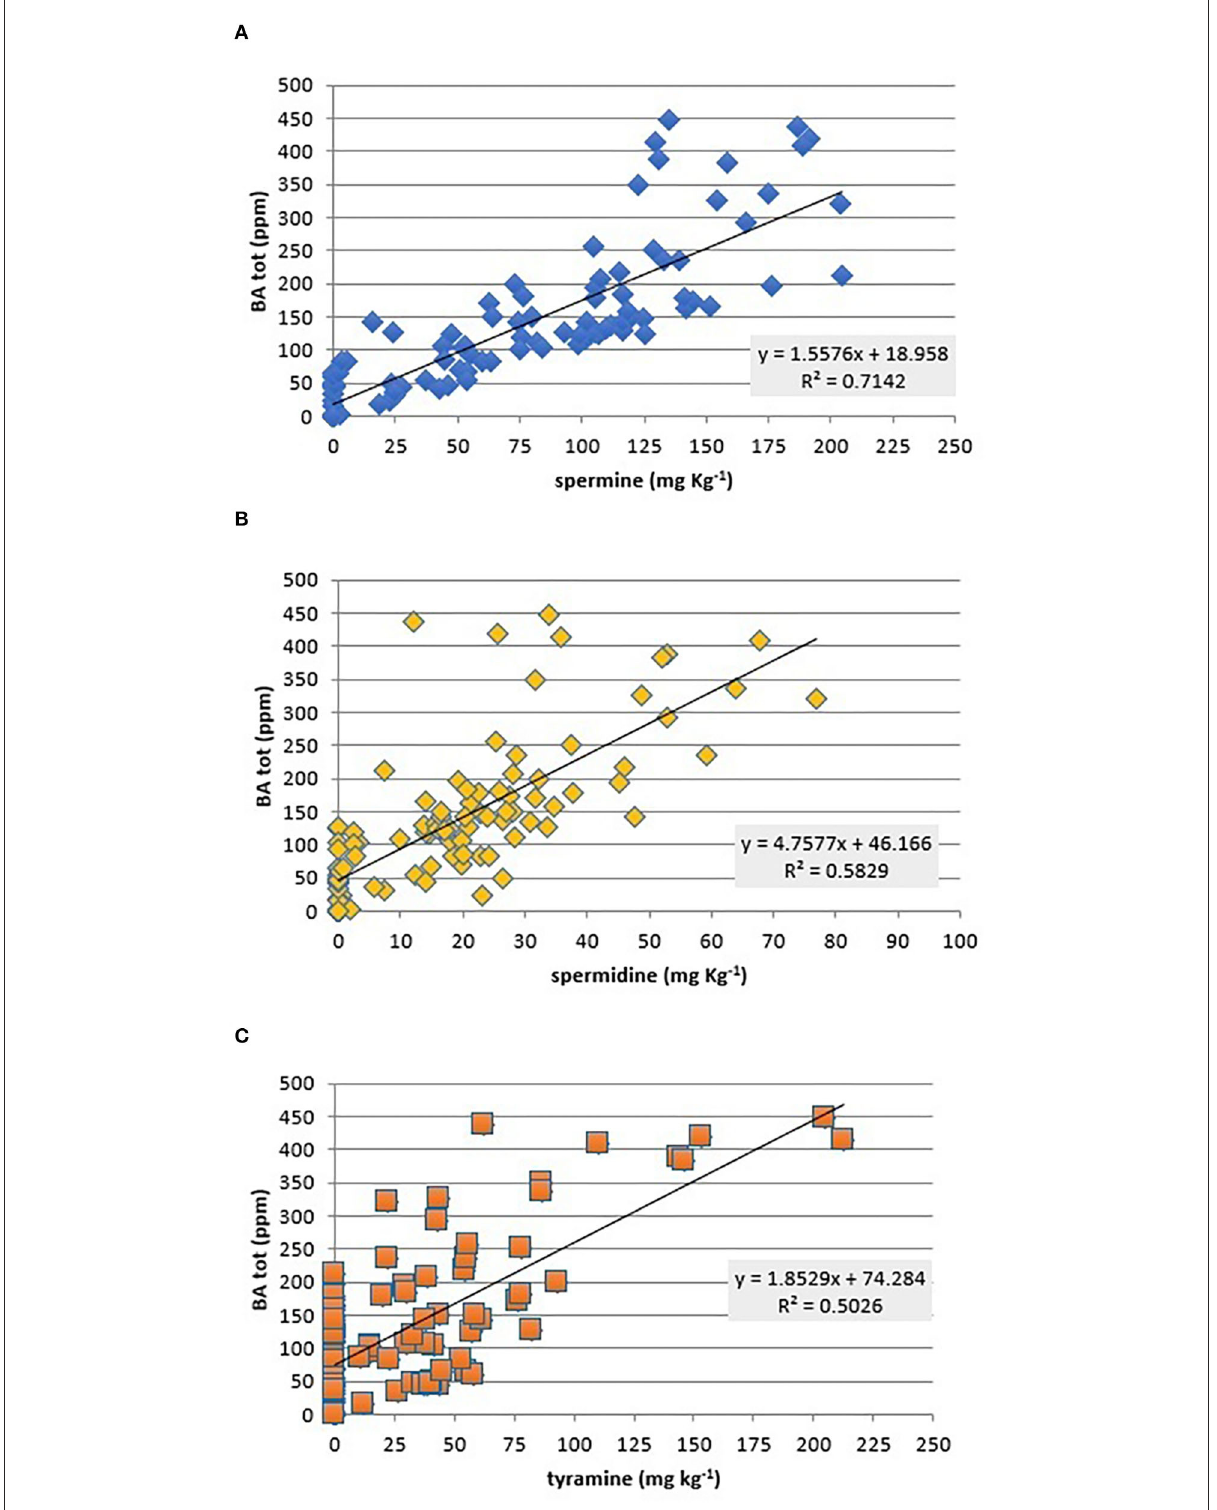
FIGURE5 Scatterplot of total biogenic amines (BA, mg kg − 1 ) against SPM (A) , SPM (B) , and TYR (C) contents and correlation coefficient values ( β ) of each single amine (PUT, HIS, and TYR) against total amines found in all investigated chicken meat samples.